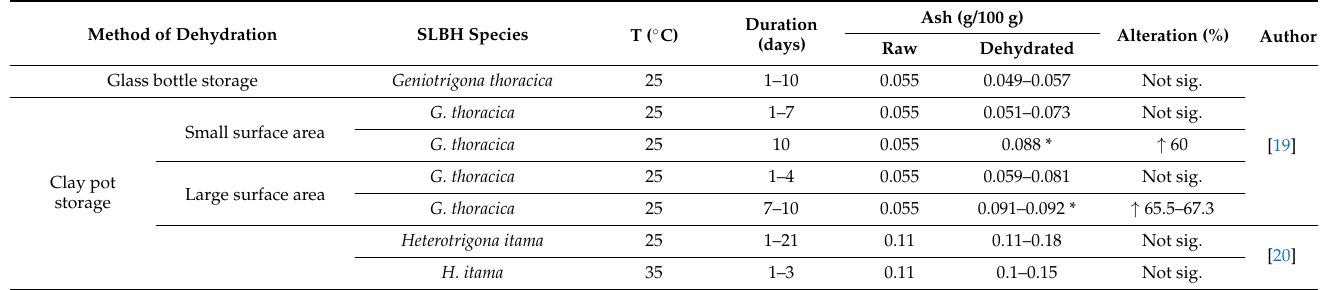
Table 6. Ash content of raw and dehydrated stingless bee honey